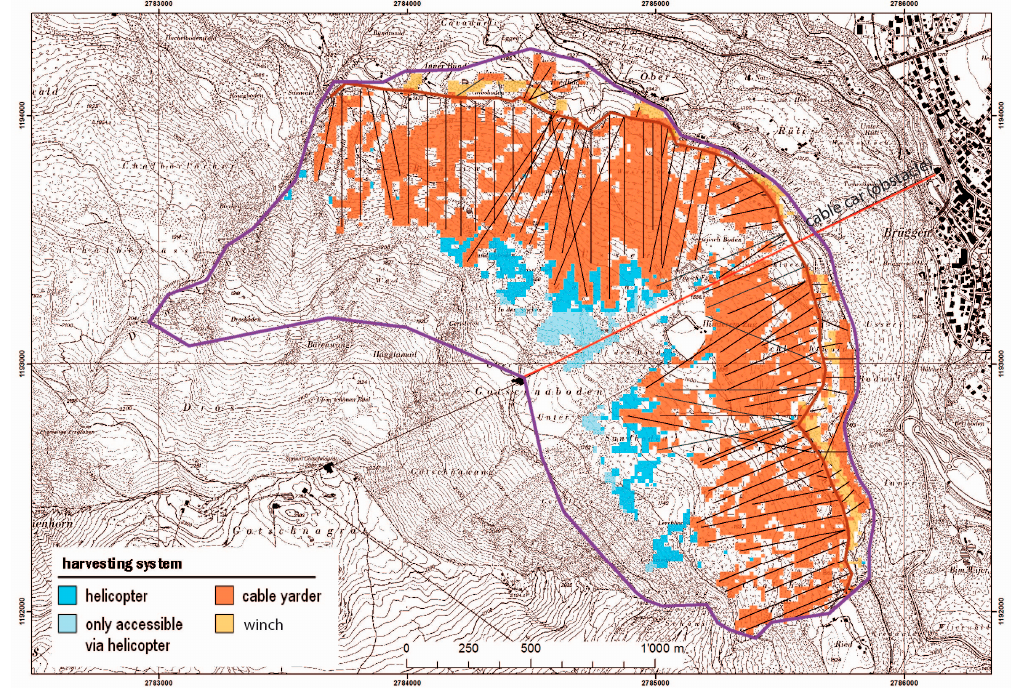
Figure 10. Aggregated results of the Pareto set consisting of the variants minimum harvesting costs (MIN-EK) (circle), minimum CR length in unfavorable direction (MIN-UR) (diamond) and MIX (square). In ( a ) the variants are characterized according to the negative net revenue and the length of CR in an unfavorable direction relative to the slope line. In ( b ) the variants are characterized according to the average harvest costs per cubic meter. (* objective weights applied to sub-units differ define merging rule).